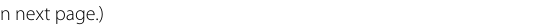
figure on next Fig. 3 Rapamycin activated autophagy by inhibiting the mTOR/ULK1 signaling pathway in HLE-B3 cells cultured under high-glucose conditions. Cells were treated with high glucose (HG, 30 mM glucose), high glucose glucose 200 nM rapamycin (RAPA) for 24 h, respectively. A The expression of molecules in the autophagy signaling pathway and autophagy + marker proteins. Statistical analysis of the relative levels of LC3II/I B and SQSTM1/p62 ( C ), p-AKT/AKT ( D ), p-mTOR/mTOR E and p-ULK1/ULK1 ( F ), n 3. G Representative TEM images of autophagosomes (arrows) in different groups. H Quantification and statistical analysis of the number of = autophagosomes, n 5. ns indicates P > 0.05; * P < 0.05, ** P < 0.01, *** P < 0.001 and **** P < 0.0001 vs. NC group; # P < 0.05, ## P < 0.01, ### P < 0.001 and = #### P < 0.0001 vs. HG group; ★ P < 0.05, ★★ P < 0.01, ★★★ P < 0.001 and ★★★★ P < 0.0001 vs. DMSO